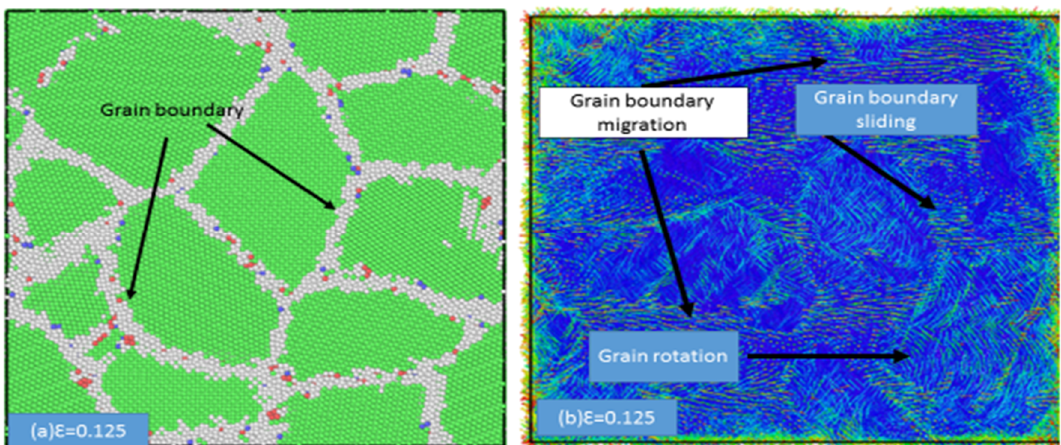
Figure 7. Snapshots showing ( a ), ( b ) grain boundary sliding and ( c ), ( d ) grain rotation for the sample with an average grain size of 3.6 nm. ( a , c ) were generated using atomic displacement vectors to visualize the grain boundary sliding and grain rotation, respectively. ( b , d ) were generated using the CNA method to visualize the grain boundary regions.